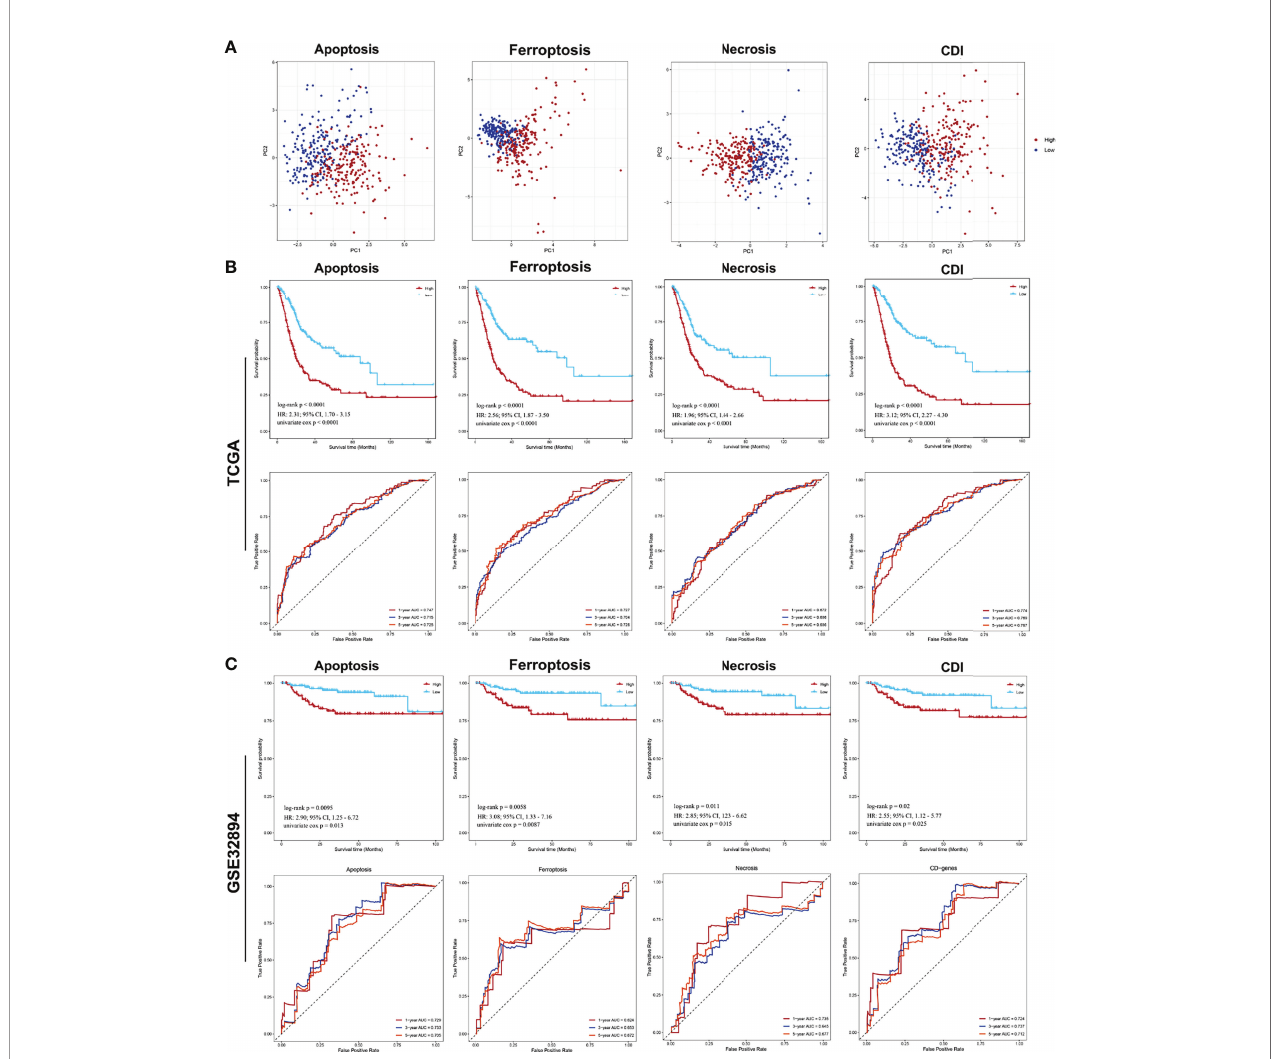
FIGURE 3 | PCA analysis of samples from each pathway and analysis of prognostic model ef fi cacy PCA and survival analysis of cell-death pathways for patients with BCa. (A) PCA analysis of the high- and low-risk groups. (B) The Kaplan – Meier survival and ROC analysis of high- and low-risk groups for patients from TCGA training cohort and GSE32894 testing